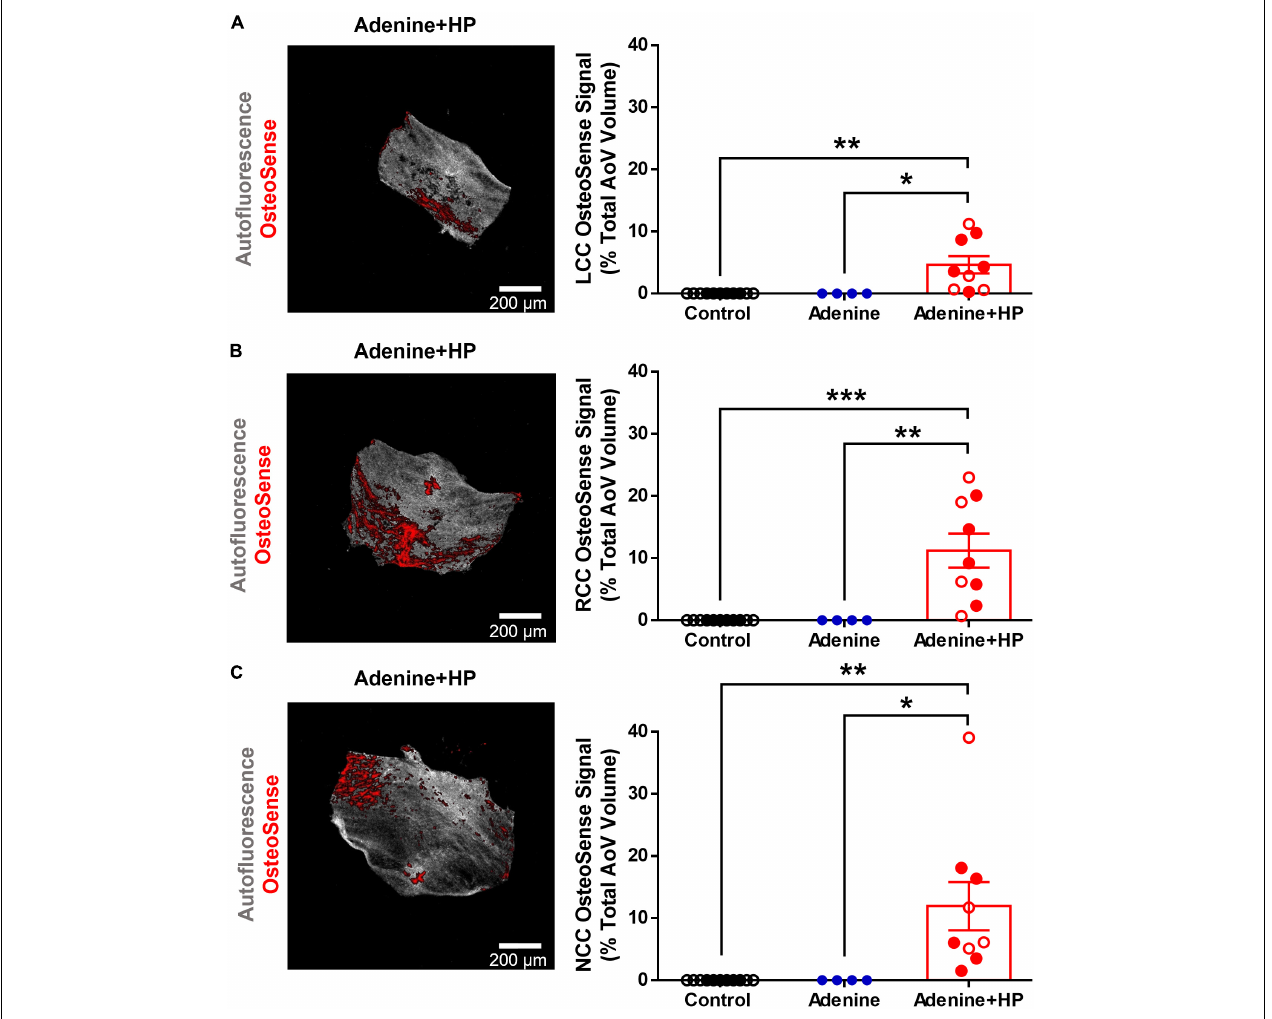
FIGURE 4 | Aortic valve calcification. Image representation and quantification of AoV calcification expressed as percent positive of OsteoSense signal normalized to the total AoV volume. (A) Left-coronary cusp (LCC). (B) Right-coronary cusp (RCC). (C) Non-coronary cusp (NCC). One-way ANOVA with Tukey’s multiple comparisons test: * P < 0.05, ** P < 0.01, *** P < 0.001. Male mice